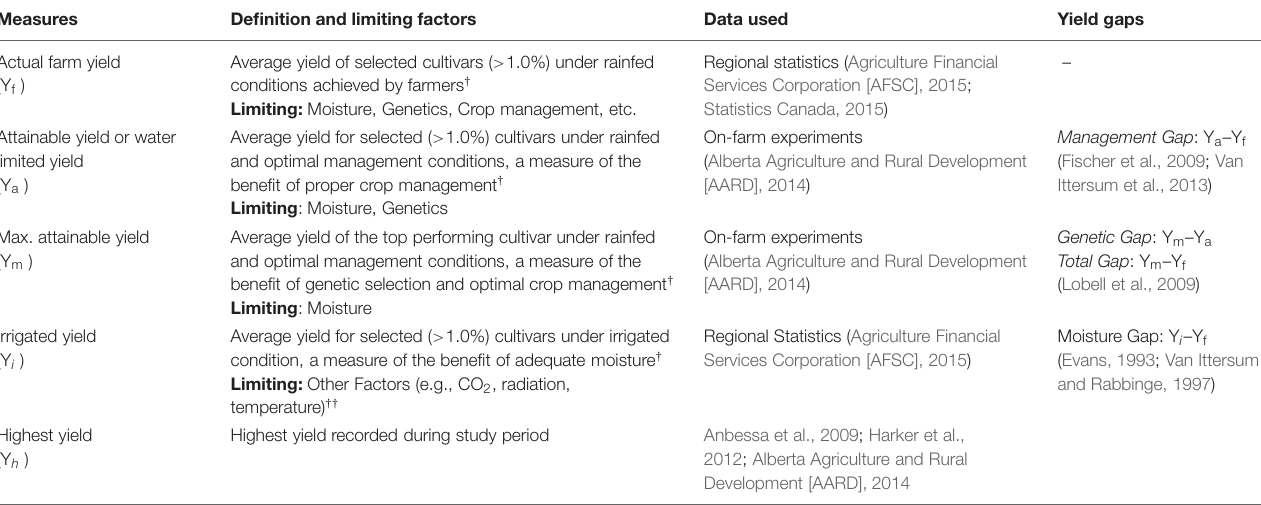
TABLE 3 | Yield metrics and yield gap calculation in wheat, barley, and